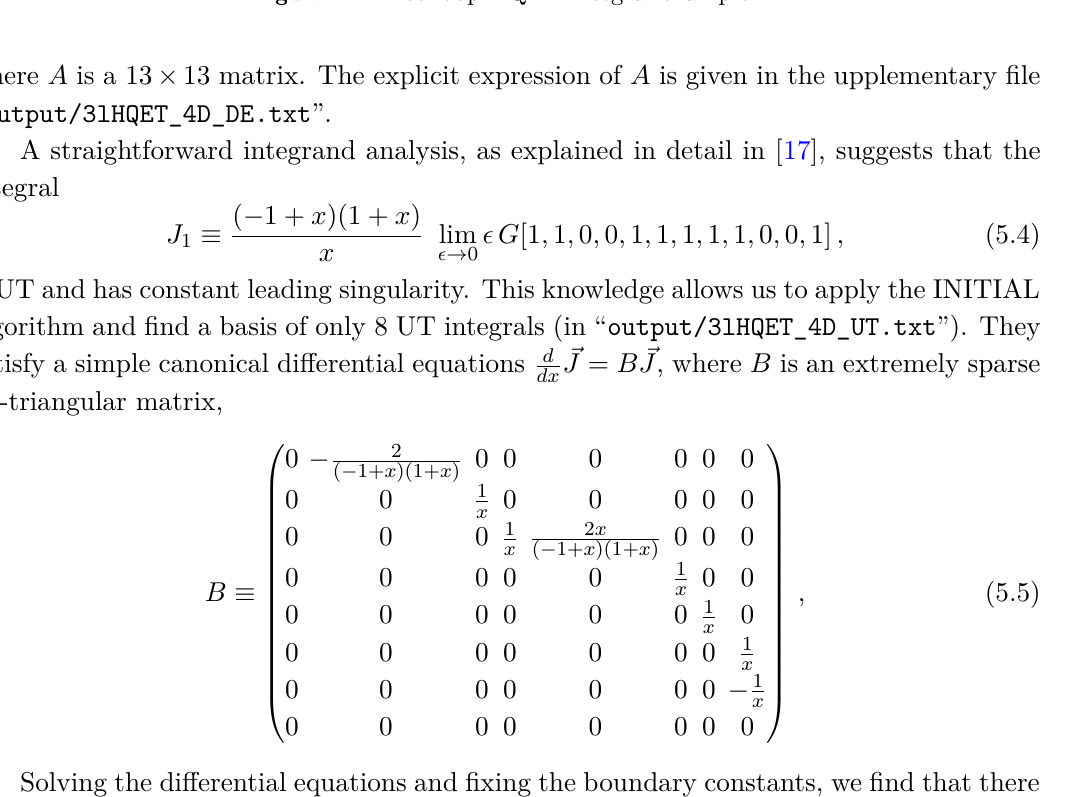
Figure 4. Three-loop HQET integral